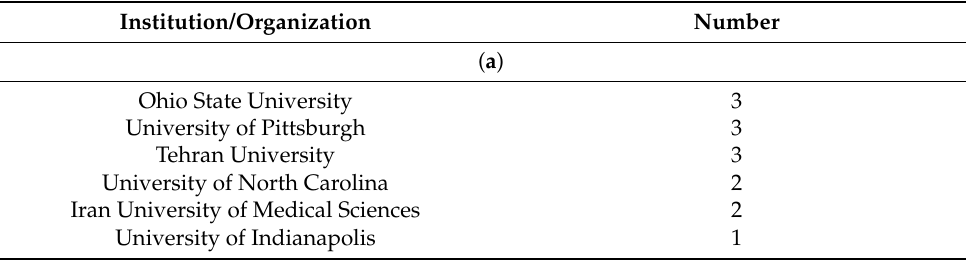
related to healthcare practitioners concerning